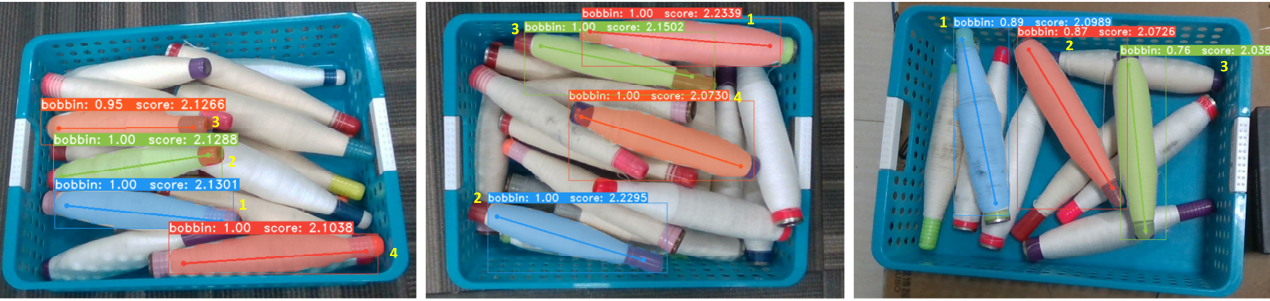
Figure 15. Scoring results for the images in Figure 13.